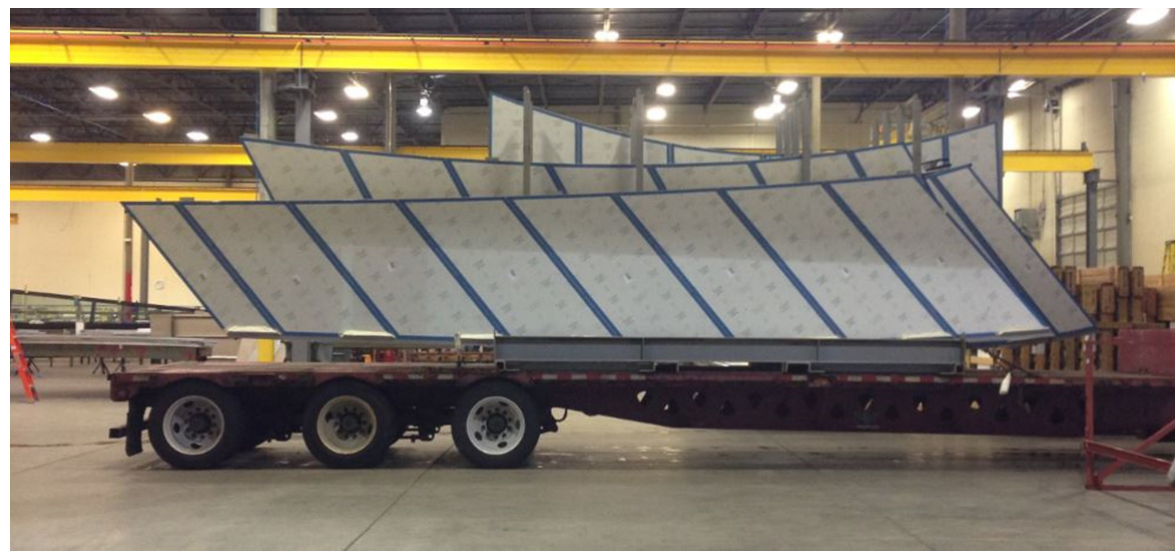
Fig. 3 Sloped Façade